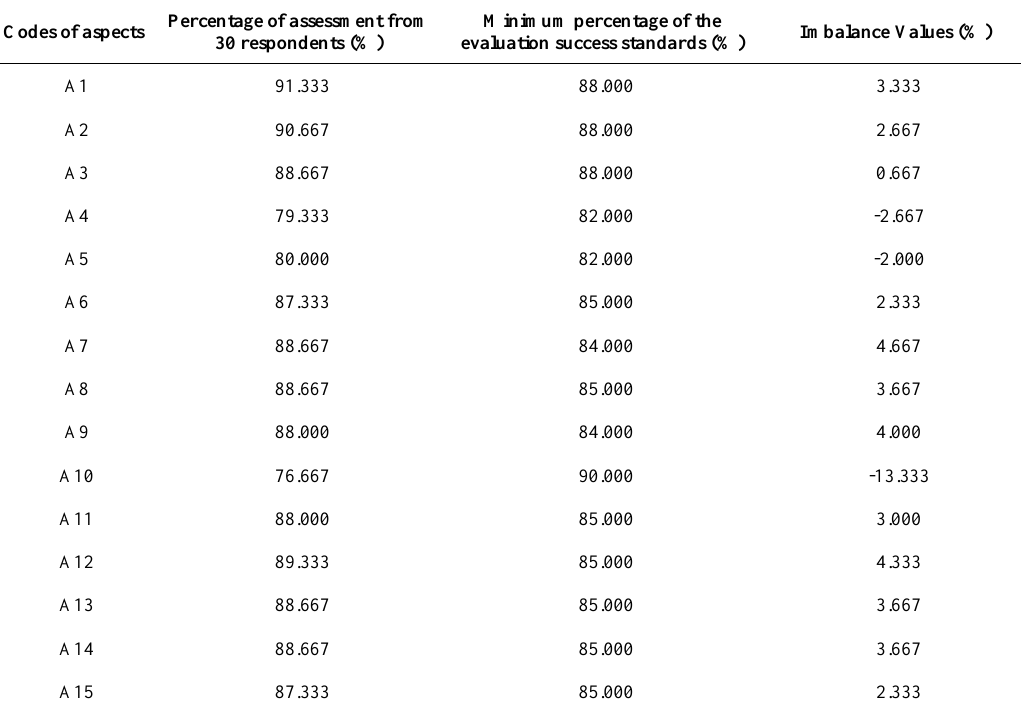
Table 3. Imbalance values for each aspect of evaluation.